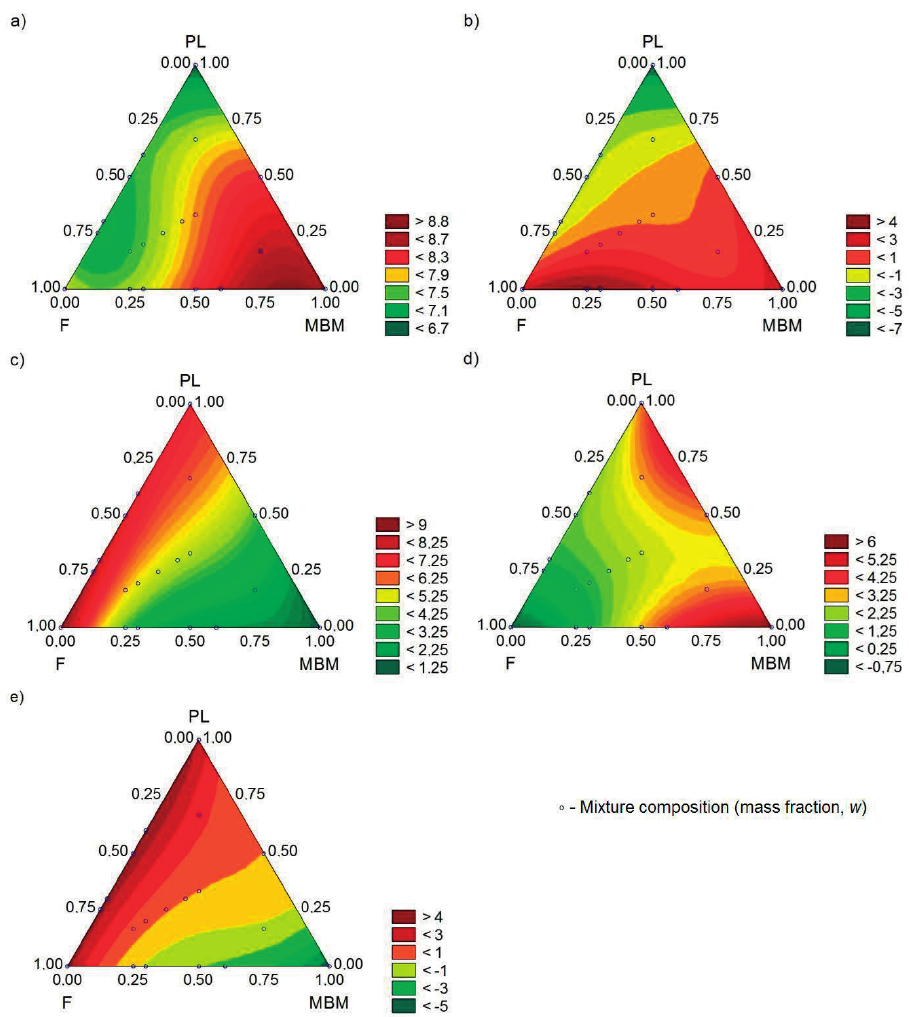
Fig. 1. Graphical presentation of the function tested object: a) the calorific value, b) content of Pc (total phosphorus content), c) content of K, d) content of Ca, e) content of